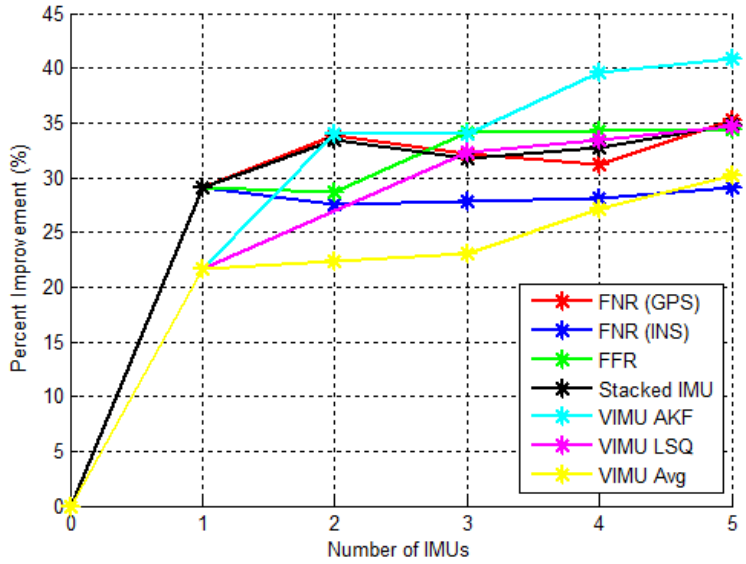
Figure 11. VIMU Accuracy as a Function of IMUs Used (Residential Data